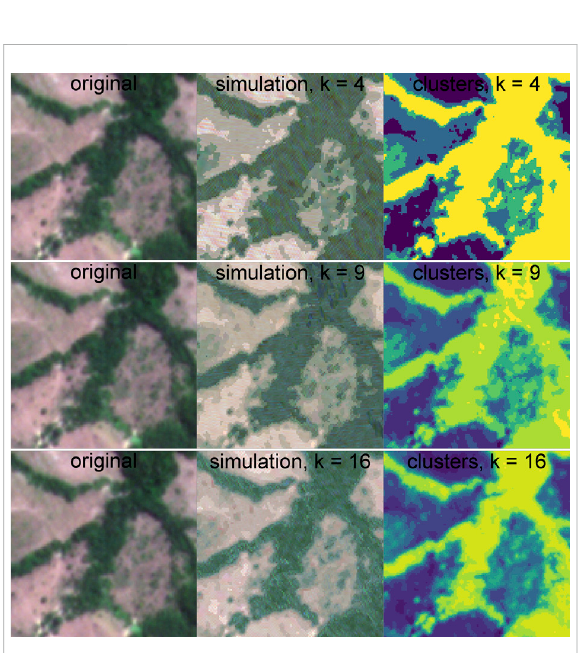
FIGURE 9 Example of the simulated image and clusters obtained with the k-textures algorithm for a number of classes k = 4, 9 and